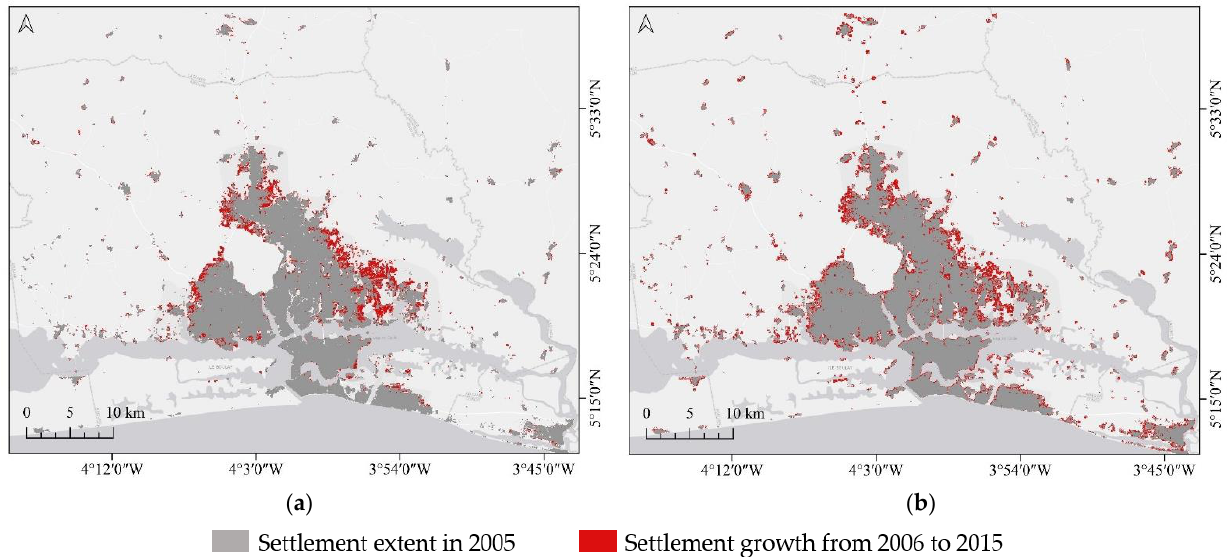
Figure 12. Actual settlement growth map and predicted settlement growth map of Abidjan based on the STM-based model from 2006 to 2015: ( a ) actual settlement growth map of Abidjan; ( b ) predicted settlement growth map from based on the ten-year strategy and MLP.